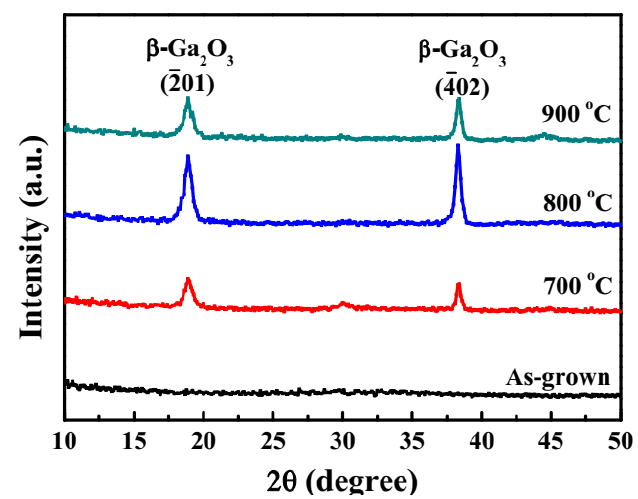
Figure 2. X-ray di ff raction (XRD) spectra of Ga 2 O 3 films annealed at various